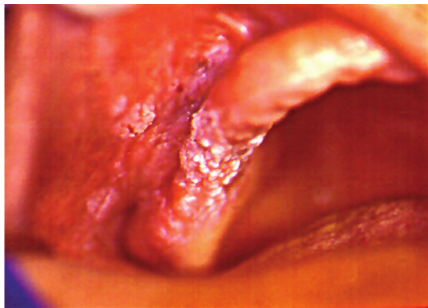
Figure 3: Histologic section showing low atypia degree, formation of keratin pearls, and, subjacent to epithelium, dense inflammatory infiltrate (hematoxylin and eosin stain, original magnification × 100).